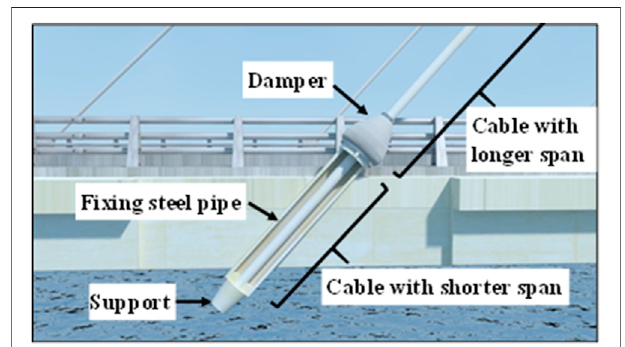
FIGURE 2 | A computer-generated image of a cable with a